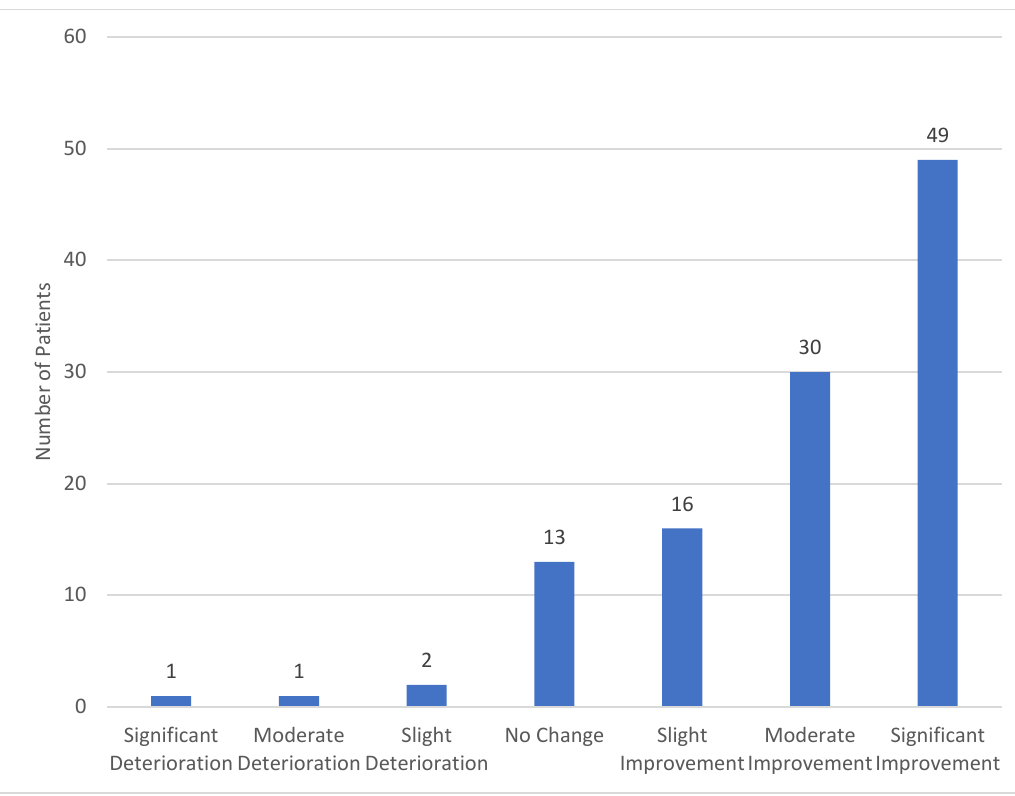
Figure 1. Global assessment of the general effect of cannabis on the patient’s condition after six months of treatment ( n = 112).